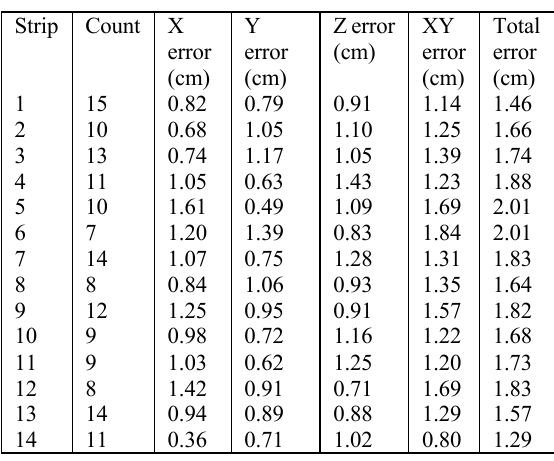
Table 5. RMSE CP points